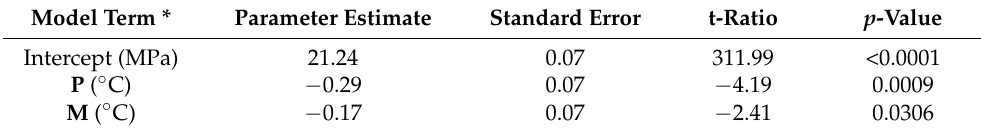
Table 5. Significant terms, estimates, and regression details of the tensile strength (TS) model. Model Term * Parameter Estimate Standard Error t-Ratio p -Value Intercept (MPa) 21.24 0.07 311.99